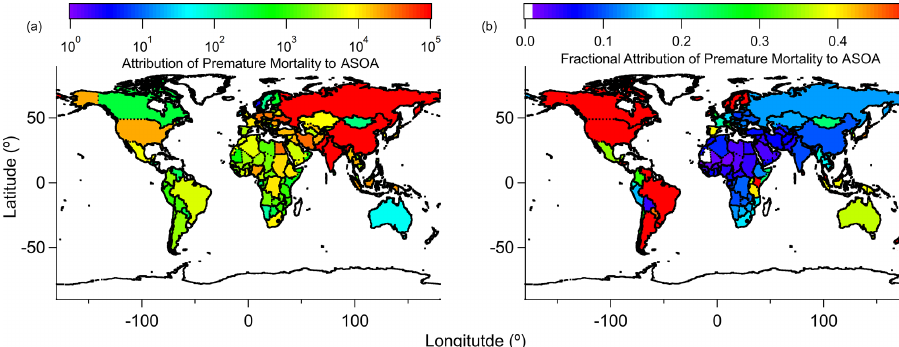
Figure 8. The 5-year average (a) estimated reduction in PM 2 . 5 -related premature deaths, by country, upon removing ASOA from total PM 2 . 5 , and (b) the fractional reduction (reduction in PM 2 . 5 premature deaths/total PM 2 . 5 premature deaths) in PM 2 . 5 -related premature deaths, by country, upon removing ASOA from GEOS-Chem. The IER methods are used here. See Figs. S9 and S12 for results using GEMM. See Fig. S10 for the 10km × 10km area results in comparison with country-level